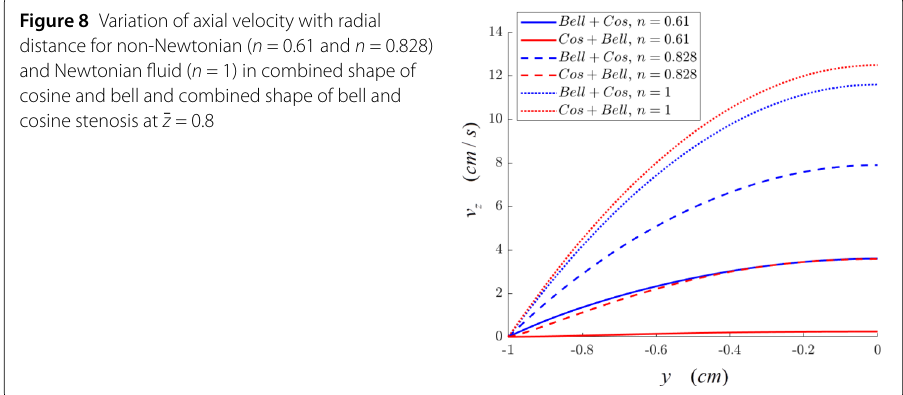
Figure 9 Variation of axial velocity with axial distance for non-Newtonian ( n = 0.61 and n = 0.828) and Newtonian fluid ( n = 1) in combined shape of cosine and bell and combined shape of bell and cosine stenosis at y =